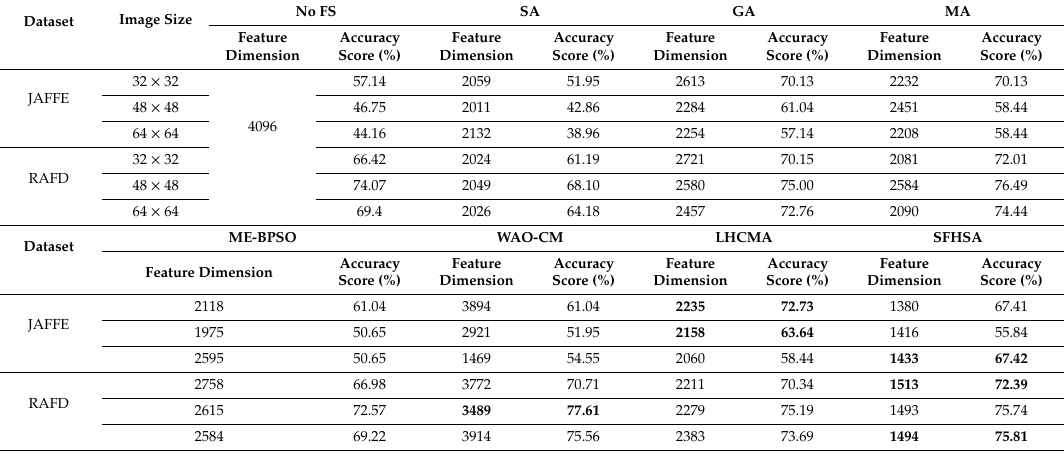
Table 4. Performance of SFHSA with respect to No FS, SA, GA, MA, ME-BPSO, WAO-CM and LHCMA for hvnLBP